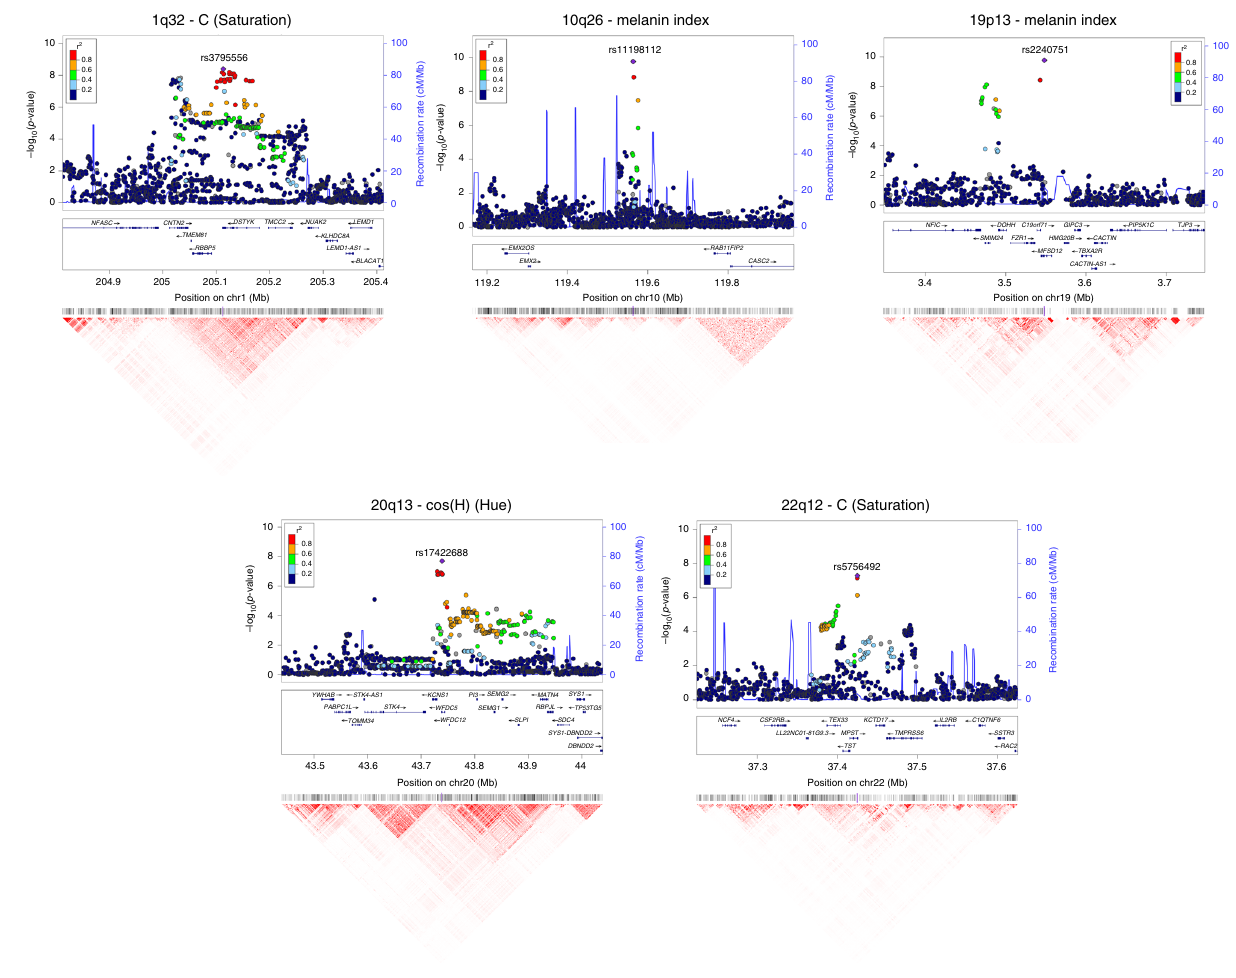
Fig. 6 Regional association (LocusZoom) plots for SNPs in the fi ve genomic regions showing novel genome-wide signi fi cant associations to pigmentation traits. Chromosomal location and trait are speci fi ed in the title of each panel. In each region, index SNPs (Table 1) are highlighted with a purple diamond. Colors for other SNPs represent the strength of LD between that SNP and the index SNP (in the 1000 Genomes AMR data). Local recombination rate in the AMR data is shown as a continuous blue line (scale on the right y -axis). Genes in each region, their intron – exon structure, direction of transcription and genomic coordinates (in Mb, using the NCBI human genome sequence, Build 37, as reference) are shown in the middle of each panel. At the bottom is shown a pairwise LD heatmap across all SNPs in a region (using r 2 , ranging from red indicating r 2 = 1 to white indicating r 2 = results are in line with other analyses of epistasis for pigmentation traits 35,36 .